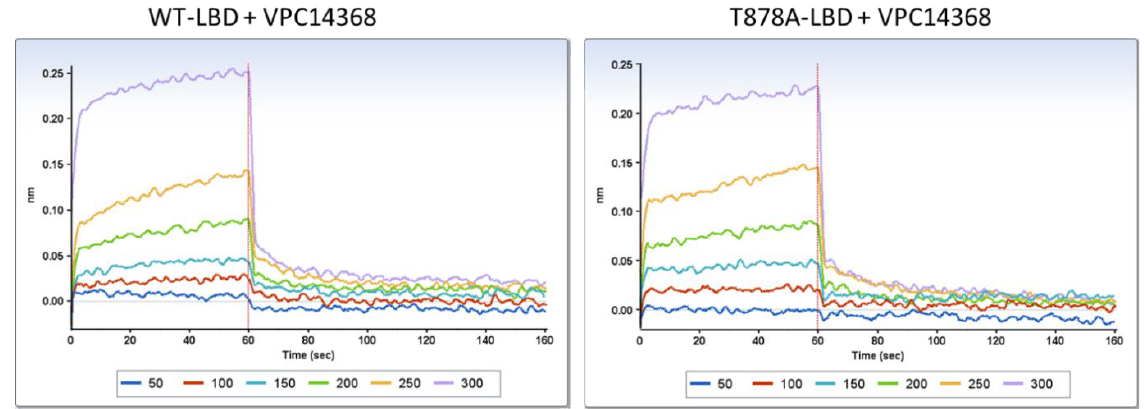
Figure 2. BLI dose-response curves (50–300 µ M) showing the direct binding of VPC14368 to WT-LBD and T878A mutant.